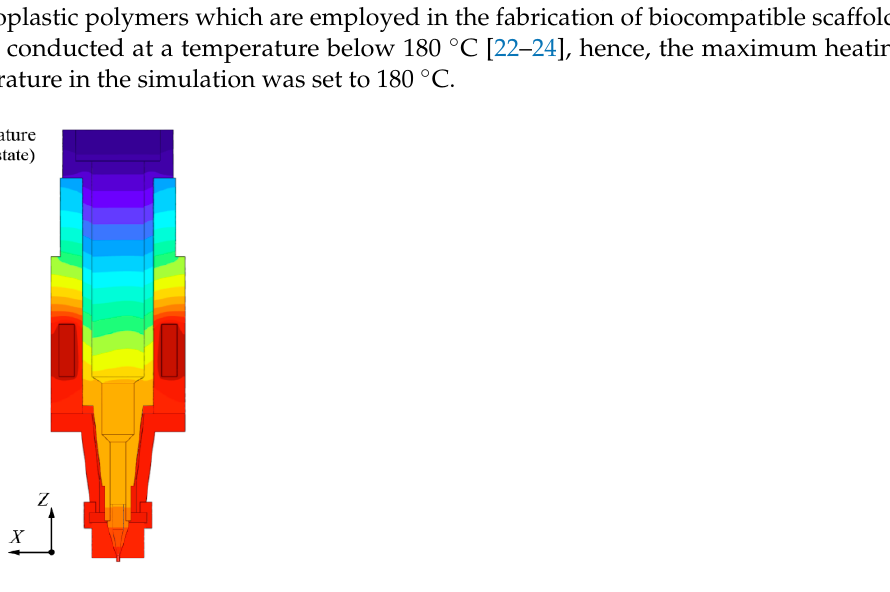
Figure 4. Temperature distribution with a heat source temperature of 180 °C .